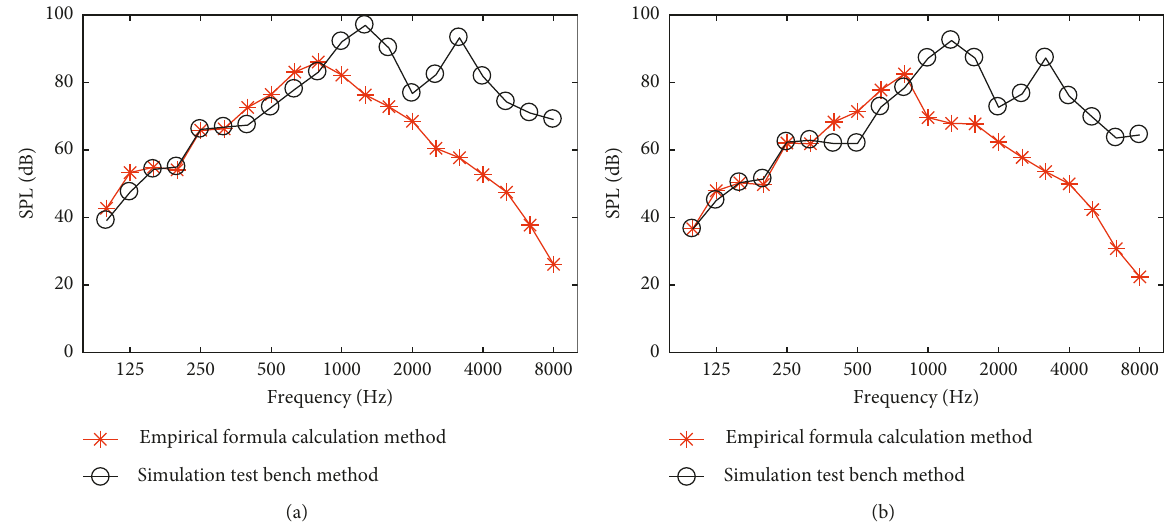
Figure 18: Comparison of combustion noise calculation results. (a) 1500rpm and no-load condition and (b) 800rpm and no-load